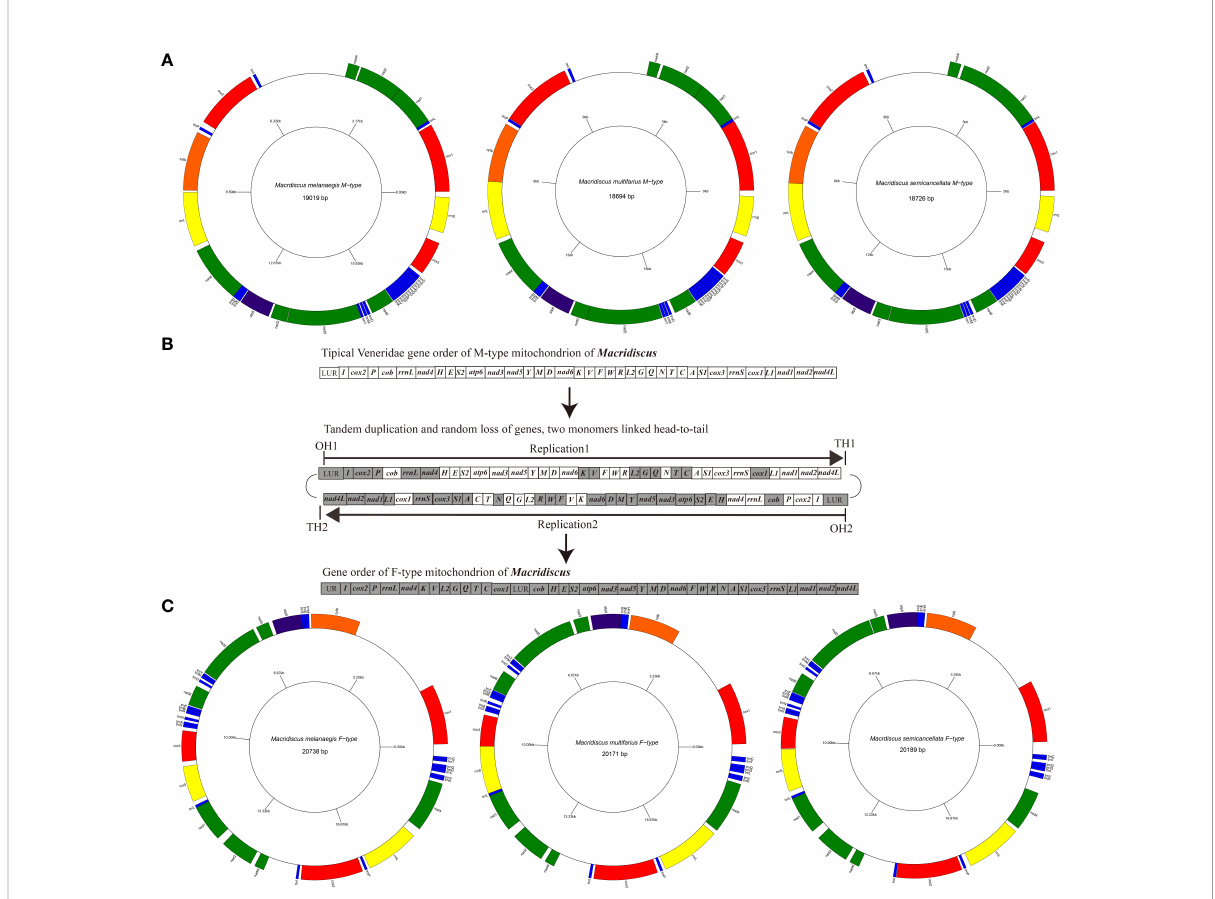
FIGURE 1 Inferred intermediate steps from the M-type gene order to F-type gene order of Macridiscus mitogenome. (A) M-type Mitochondrial gene maps of the three Macridiscus species. All the genes transcribed from the plus strand. Genes are mapped in anticlockwise starting from cox1 . (B) Intermediate steps of Tandem duplication and random loss of genes. Protein-coding genes tRNA rRNA and LUR are indicated by boxes. OH and TH indicate the heavy-strand origin and termination of replication. The direction of transcription is shown by arrows. (C) F-type Mitochondrial gene maps of the three Macridiscus